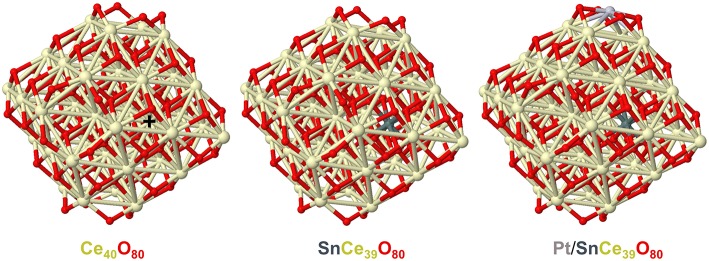
Geometric structures of CeO2-based nanoparticles calculated to analyze effects of doping Sn ions on the nearest distances from the latter to O and Ce ions. Color coding for atoms: Ce—beige, O—red, Sn—dark gray, Pt—light gray. The nearest distances to the Ce4+ ion marked by + in the Ce40O80 model: Ce-O-2.292, 2.292, 2.293, 2.295, 2.358, 2.358, 2.361, 2.361 (average 2.326); Ce-Ce-3.732, 3.734, 3.737, 3.738, 3.744, 3.746, 3.747, 3.752 (average 3.741). The nearest distances to the Sn4+ ion in the SnCe39O80 model: Sn-O-2.181, 2.184, 2.187, 2.189, 2.264, 2.269, 2.276, 2.280 (average 2.229); Sn-Ce-3.687, 3.687, 3.688, 3.693, 3.717, 3.724, 3.726, 3.730 (average 3.707). The nearest distances to the Sn4+ ion in the Pt/SnCe39O80 model: Sn-O-2.175, 2.176, 2.205, 2.210, 2.238, 2.246, 2.260, 2.266 (average 2.222); Sn-Ce-3.682, 3.691, 3.691, 3.700, 3.714, 3.717, 3.725, 3.726 (average 3.706). All the distances are in Å. Atomic coordinates and total energies of the displayed structures are given in the Supplementary Material.